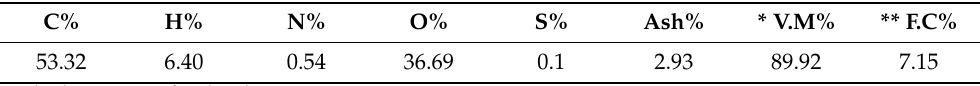
Table 1. The elemental composition of black pine ( Pinus Nigra ) (dry basis).